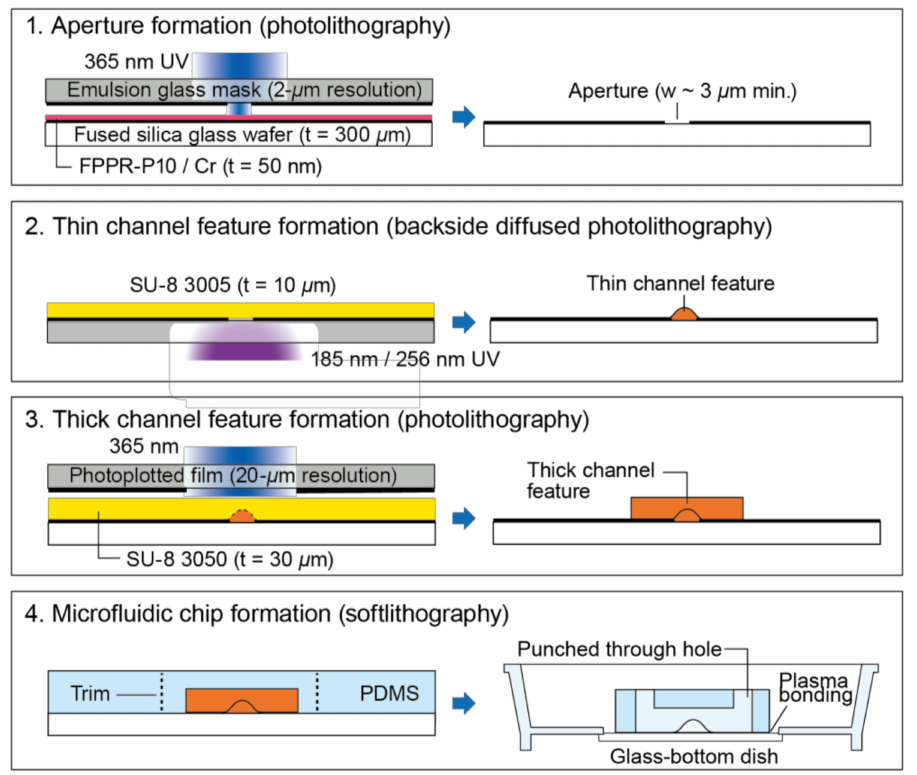
Figure 2. Fabrication of a microfluidic chip with thin and thick mixed-height microchannels. The